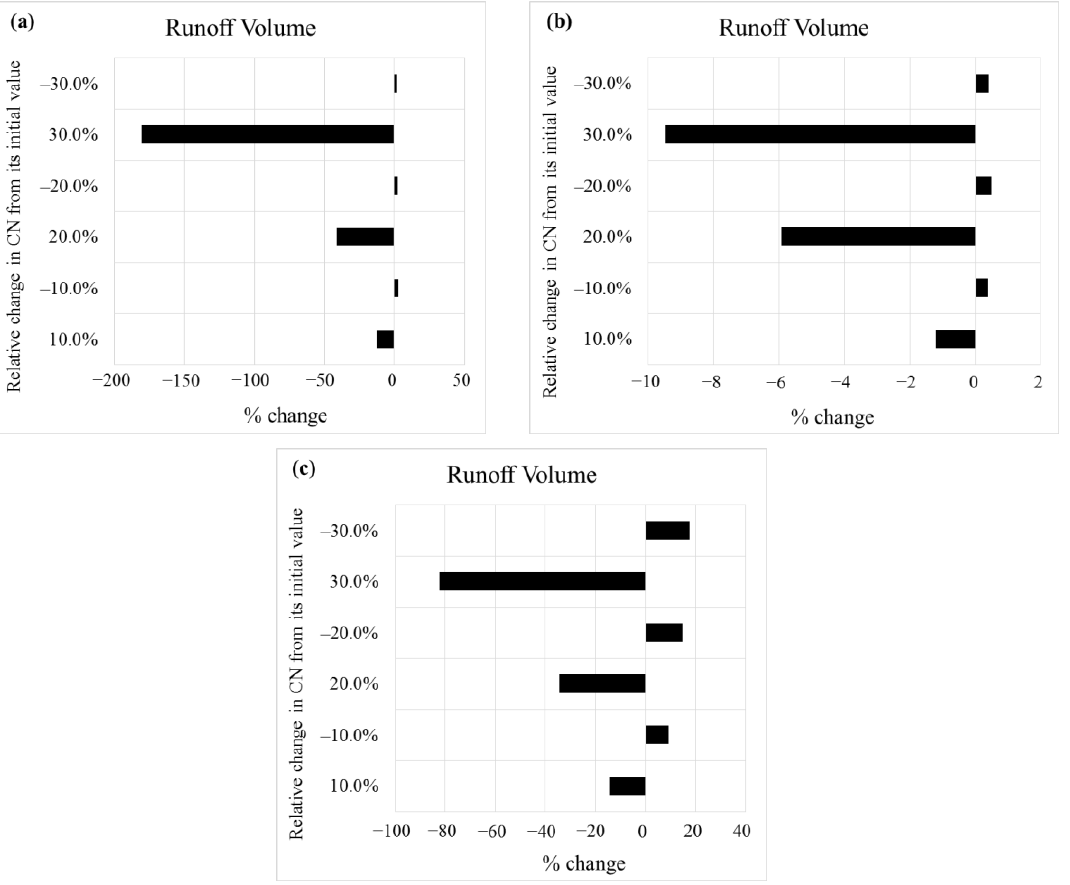
Figure 7. Sensitivity analysis for ( a ) CN for Row Crop (SR — Good), ( b ) CN for Row Crop (C + CR — Figure7. Sensitivityanalysisfor( a )CNforRowCrop(SR—Good), ( b )CNforRowCrop(C + CR—Good), Good), ( c ) CN for Woods (Good), Pawcatuck River Watershed. ( c ) CN for Woods (Good), Pawcatuck River